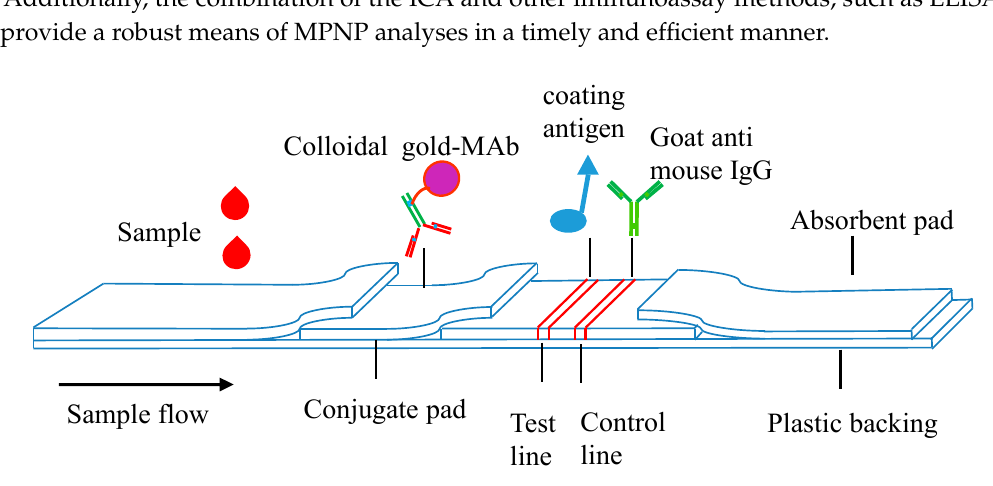
Figure 3. Schematic view of the lateral flow strip [91] Reprinted with permission from Huihua Qu et al. (2015), Copyright 2015 Biosensors and Bioelectronics.